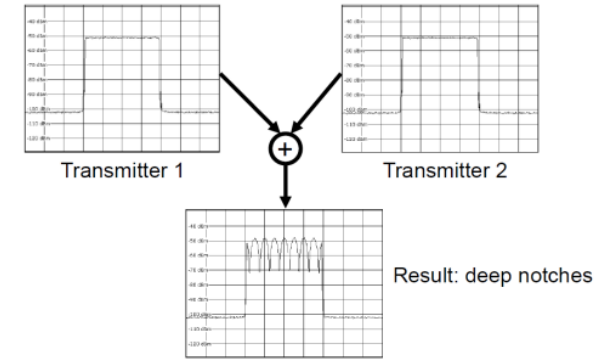
Figure 6. DVB-T2 Frequency Selective